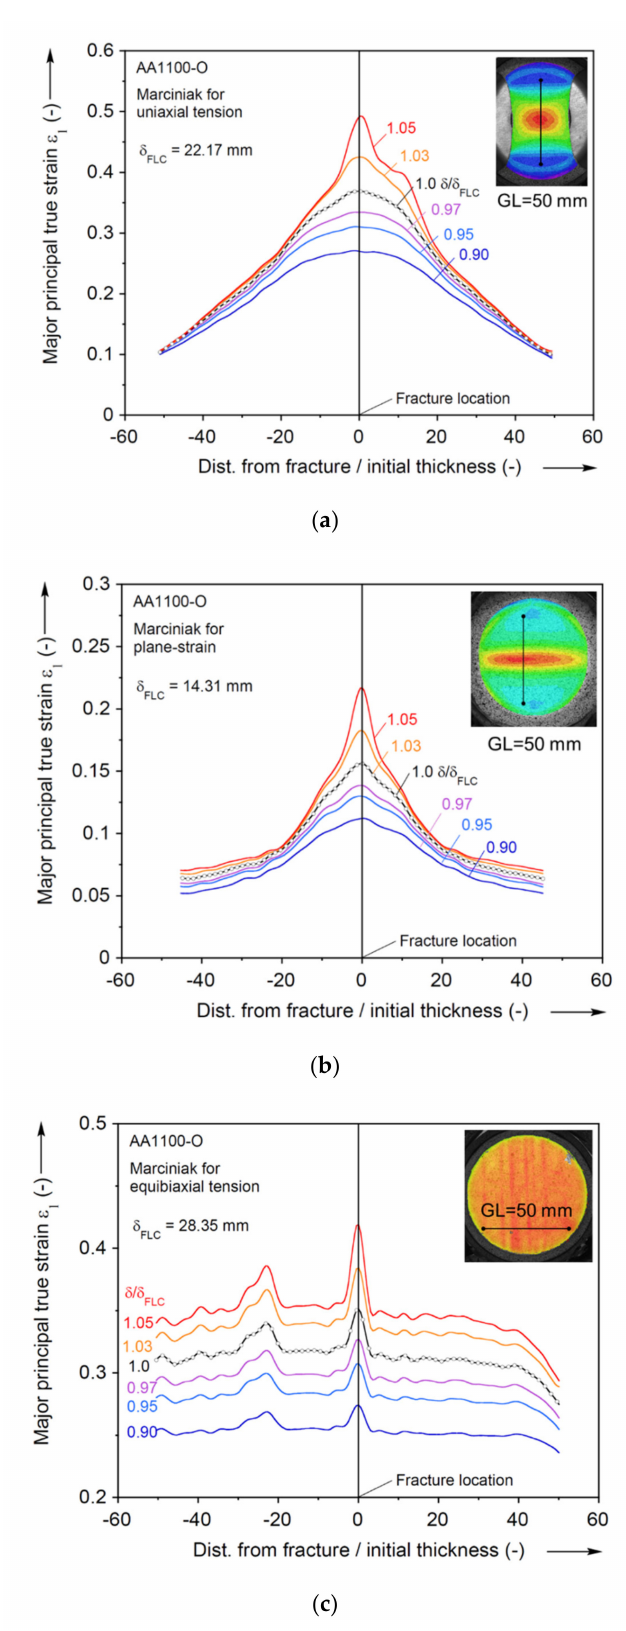
Figure 20. Strain profile near FLC limit identified by second derivative method of major principal strain for ( a ) uniaxial tension, ( b ) plane-strain tension, and ( c ) equibiaxial tension. The strain axes are in di ff erent scales, appropriate to each